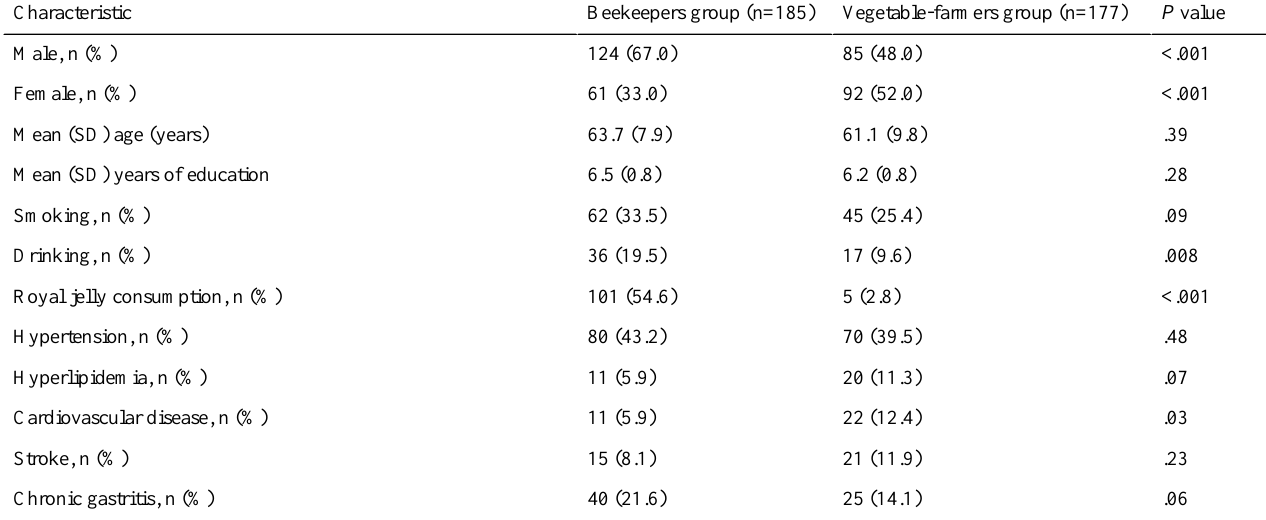
Table 1. General results and disease prevalence rate between the beekeepers group and the vegetable-farmers group, sampled from Wuhan, China, between February and April 2016.